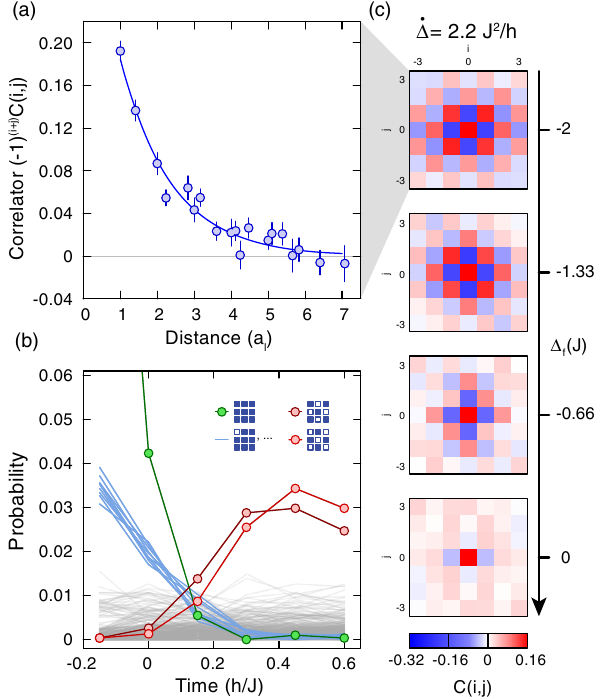
FIG. 4. Characterizing many-body states during and after a slow quench. (a) Spatial decay of the correlations after a sweep _ Δ ¼ 2 with . 2 J 2 =h , with an exponential fit that yields a correlation length ξ ¼ 1 . 4 ð 1 Þ a l . (b) Time evolution of the probabilities of observing different configurations in 3 × 3 subsystems, not corrected for detection efficiencies. The prob- abilities are shown for the two antiferromagnetic states (red), the all-grounds state (green), one-Rydberg-atom states (blue), and all other states (grey). The evolution is shown during a ramp with _ Δ ¼ 4 . 4 J 2 =h . The antiferromagnetic configurations become most probable at the end of the quench. (c) Full correlation matrices C ð i; j Þ at different final detunings during a slow quench _ Δ ¼ 2 with . 2 J 2 =h , showing the growing range of the antiferro- magnetic